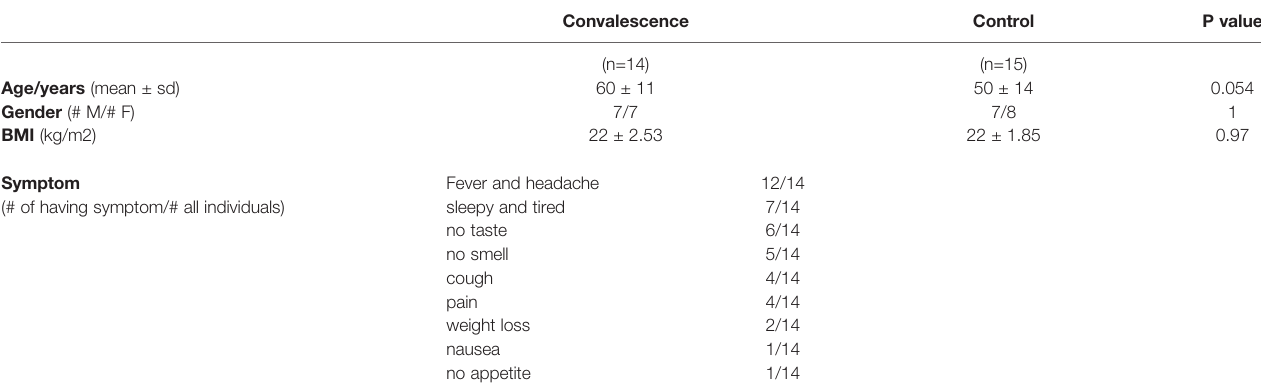
TABLE 1 | General characteristics of the study